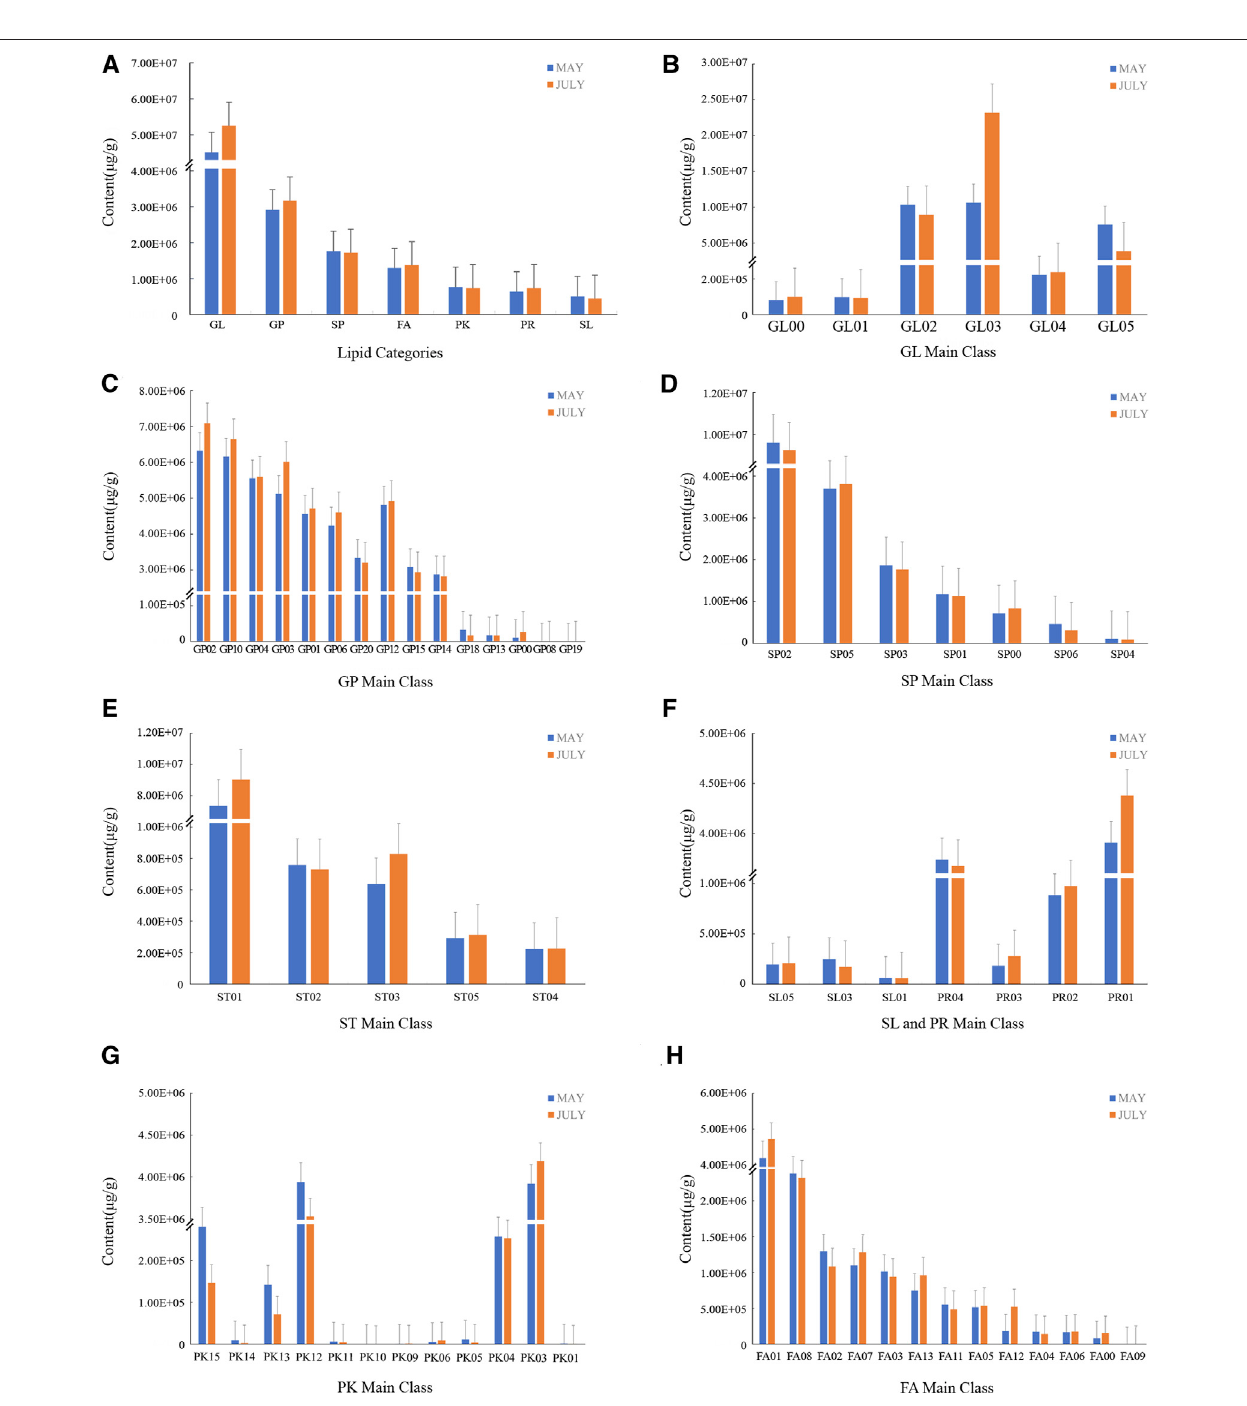
FIGURE 3 | The content of various lipid components of FF differed with growth stage. The May sample is represented in blue and the July sample in red. For each sample date, (A) The composition of total lipids contained in FF, (B) Glycerolipids (GL), (C) Glyceropnospholipids (GP), (D) Sphingolipids (SP), (E) Sterol Lipids (SL), (F) Saccharopilipids (SL) and Prenol Lipids (PR), (G) Polyketides (PK), (H) Fatty Acyls